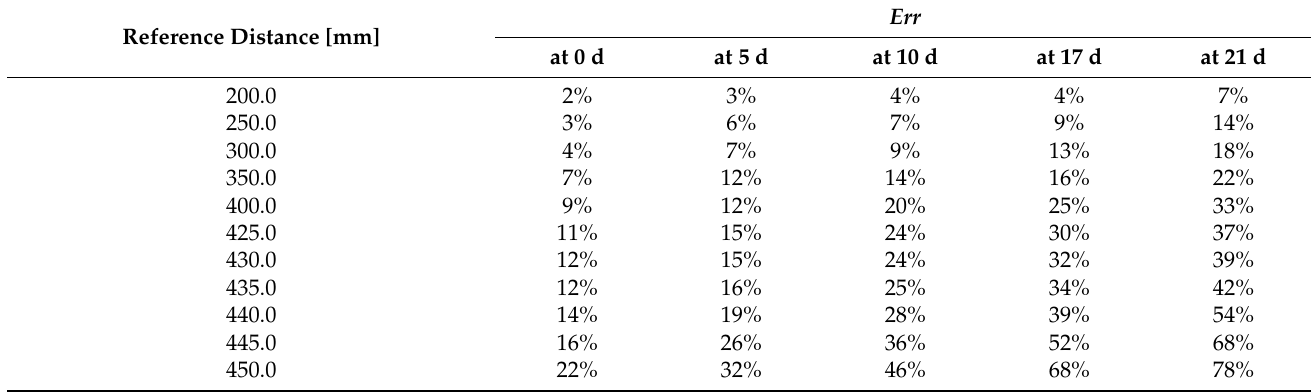
Table A3. Influence of the accelerated aging on the percentage error Err (Figure